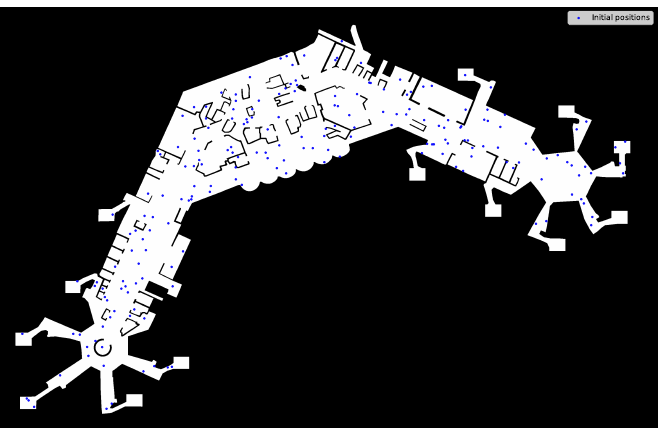
Figure 4. Exemplary starting point configuration, individual starting positions are shown as blue points.